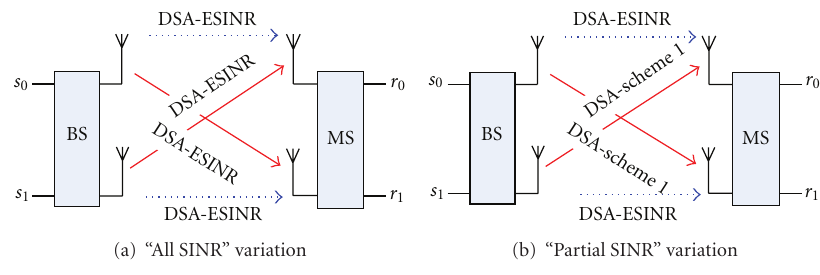
Figure 2: Variations of the proposed DSA-SINR